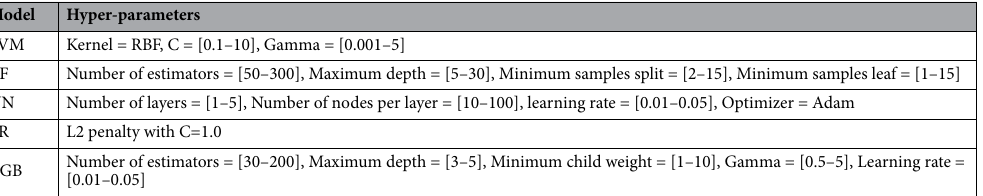
Table 1. Hyper-parameters and architecture of the models. Optimal hyper-parameters values were obtained using a grid search over cross-validated models for each architecture.